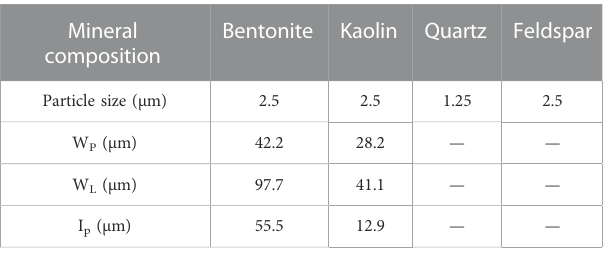
TABLE 3 Parameters of different groups of specimens.